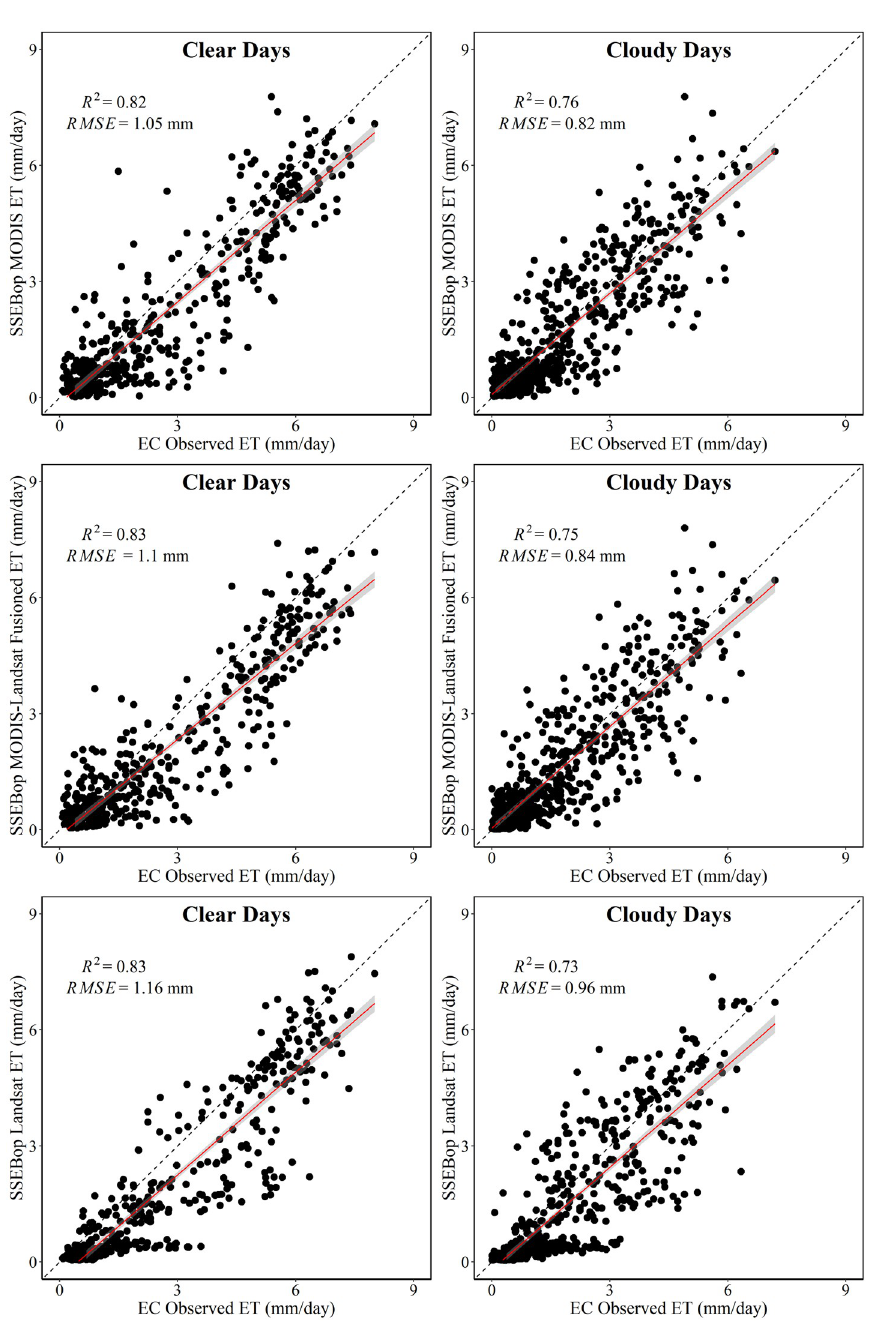
Fig 6. Comparison of estimated ET results with EC observations on clear and cloudy